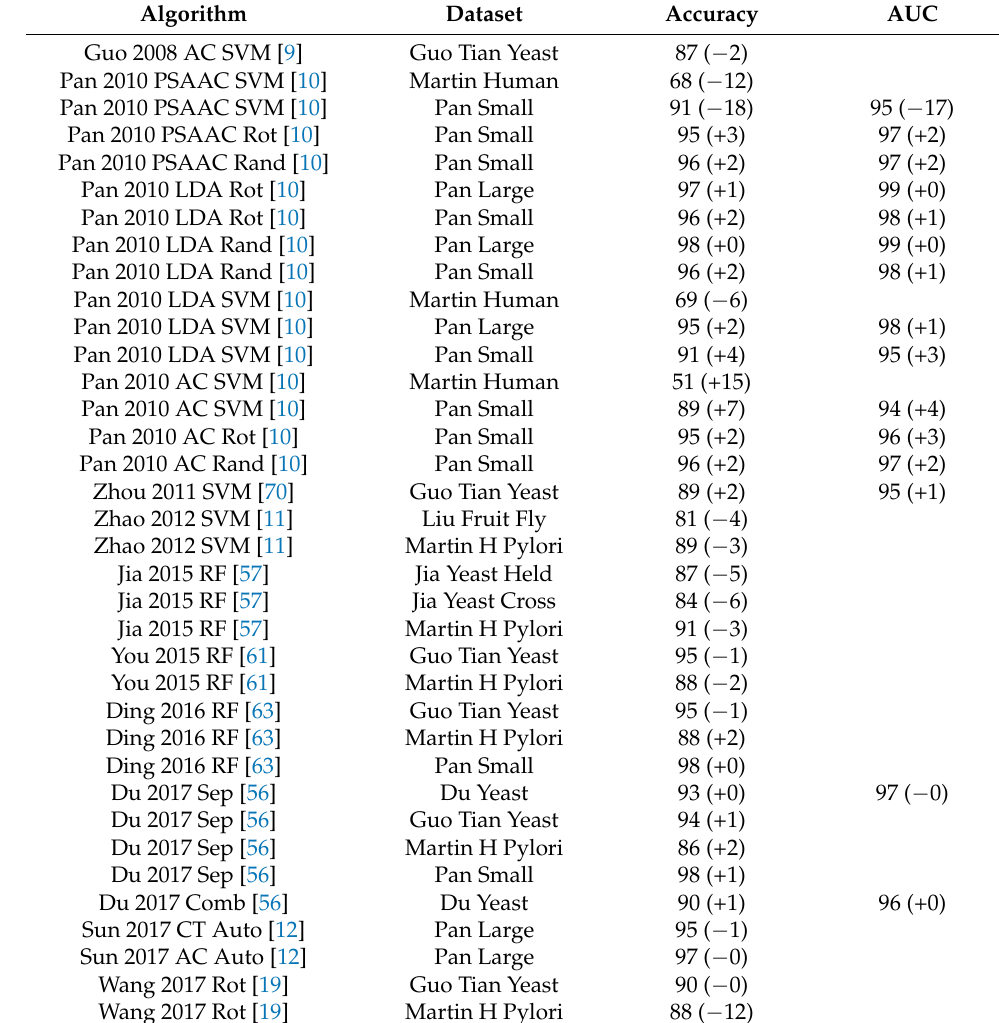
Table 4. Comparison of previous results to our implementations (increase or decrease of our imple- mentations is listed in parenthesis, relative to the scores from the original